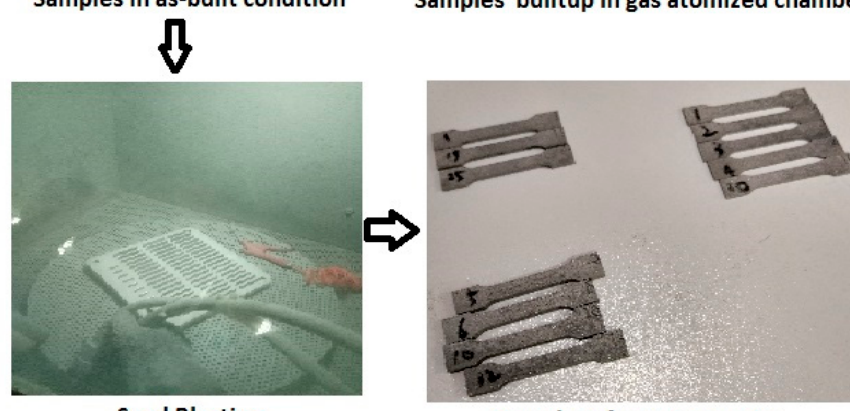
Figure 4. Overall flow of the manufacturing process.